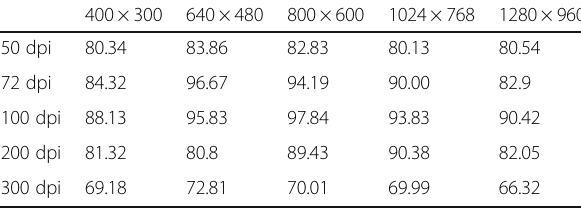
Table 2 Recognition rates with different resolutions and